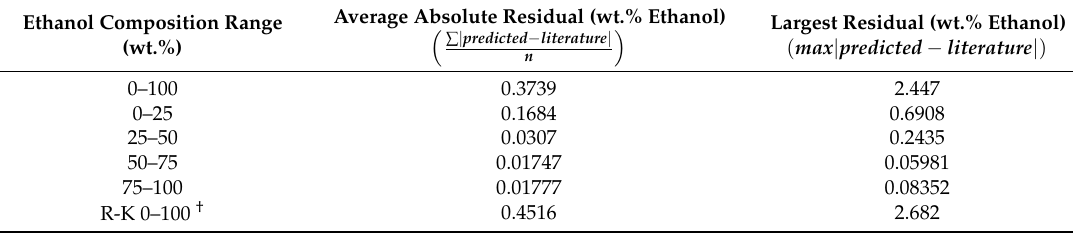
Table 3. Average absolute deviation and largest absolute deviation between ethanol compositions calculated using the polynomial model and published literature data for several composition ranges. † Calculations made by using a solving tool to calculate mixture composition using the Redlich-Kister